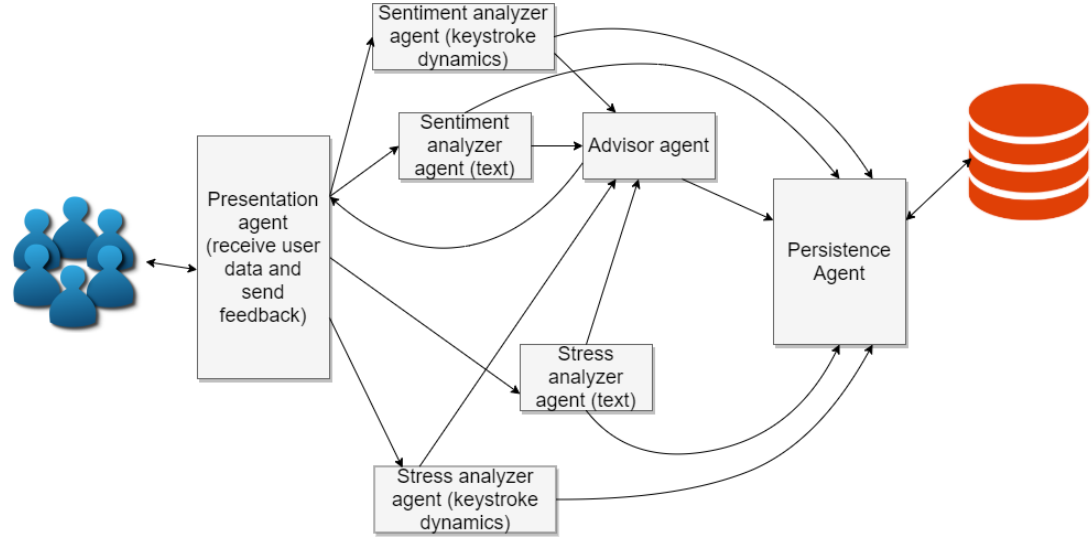
Figure 1. Architecture of the multi-agent system